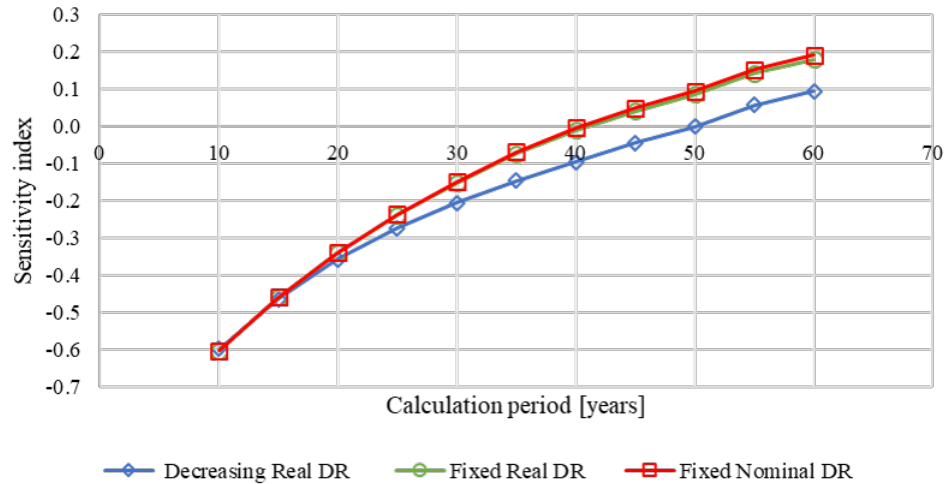
Figure 4. Sensitivity index for three discount rates (DR) as a function of calculation period.